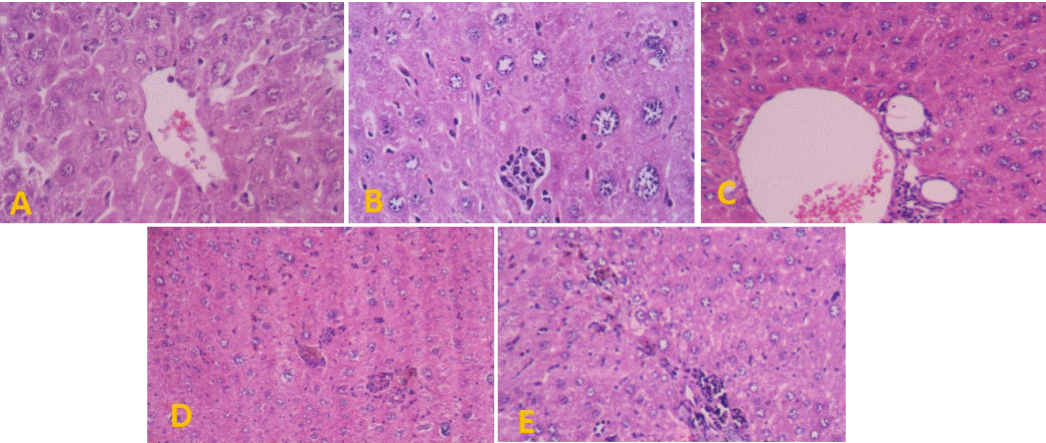
FIGURE 4 - H&E staining of liver tissues of normal and iron-overloaded mice (40× magnification). A: normal liver tissue, B: liver tissue From Iron-overloaded mice, C: liver tissue from an iron- overloaded mice receiving DFO as i.p . injection, D: liver tissue from iron-overloaded mice receiving 30 mg/kg/day naringin, and E: tissue from an iron- overloaded mice receiving 60 mg/kg/day naringin.